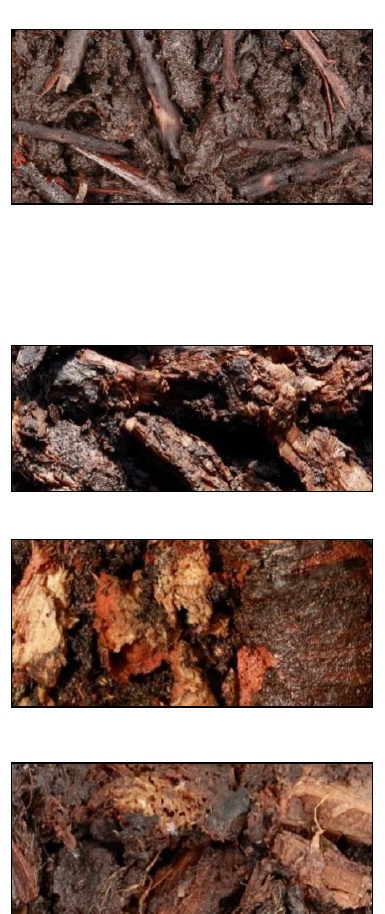
Straw yellow to reddish-light brown, loosely bedded moss plants with relatively thick, soft, bright-transparent (rarely dark) small and apparently leafless stems; small ovate to lanceolate leaves, never shiny and always without a leaf vein; colour brightens when peat is compressed; when more highly decomposed, colour varies from moderately red-brown to dark red-brown and moss remains are more difficult to recognise.